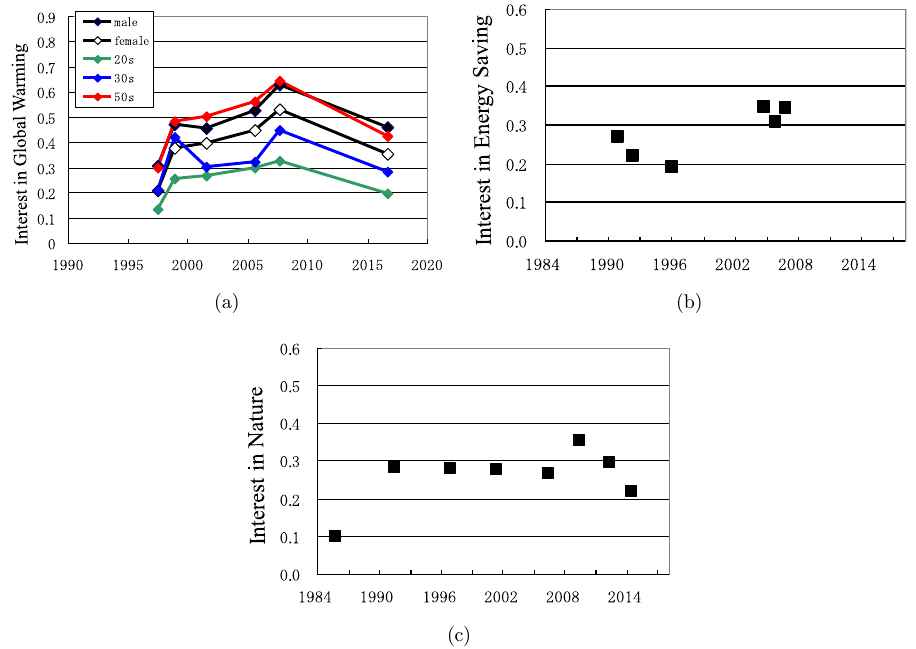
Fig. 1. Time-variation of the proportion of Japanese who are very interested in (a) the global warming, (b) the energy saving and (c) nature. Lines drawn in (a) are just for the guide to eyes. Only the average values for the respondents are shown in (b) and